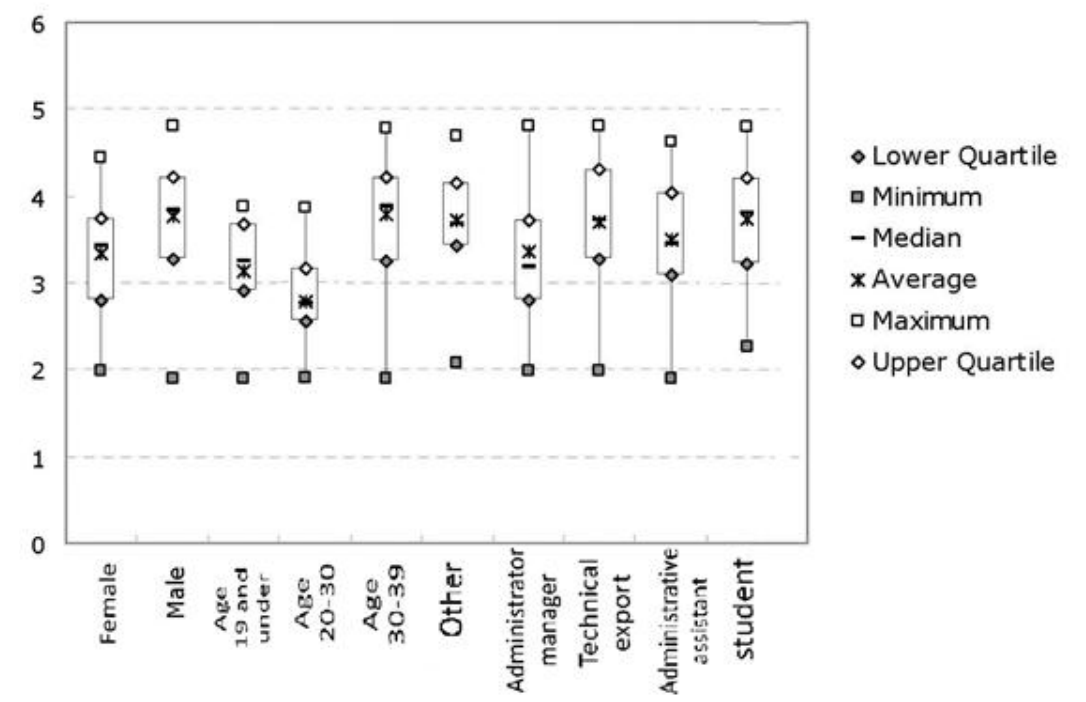
Fig. 7: Spatial familiar index according to